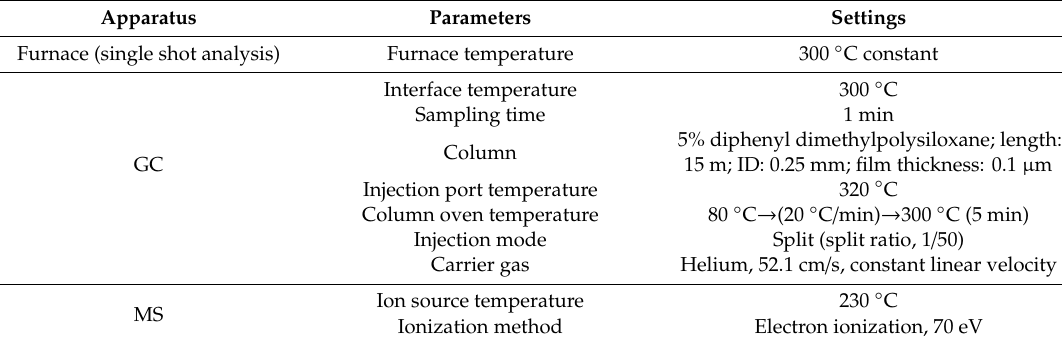
Figure 2. Schematic of the thermal desorption–gas chromatography–mass spectrometry (TD–GC–MS) system used. Table 2. TD heating conditions and GC–MS parameter